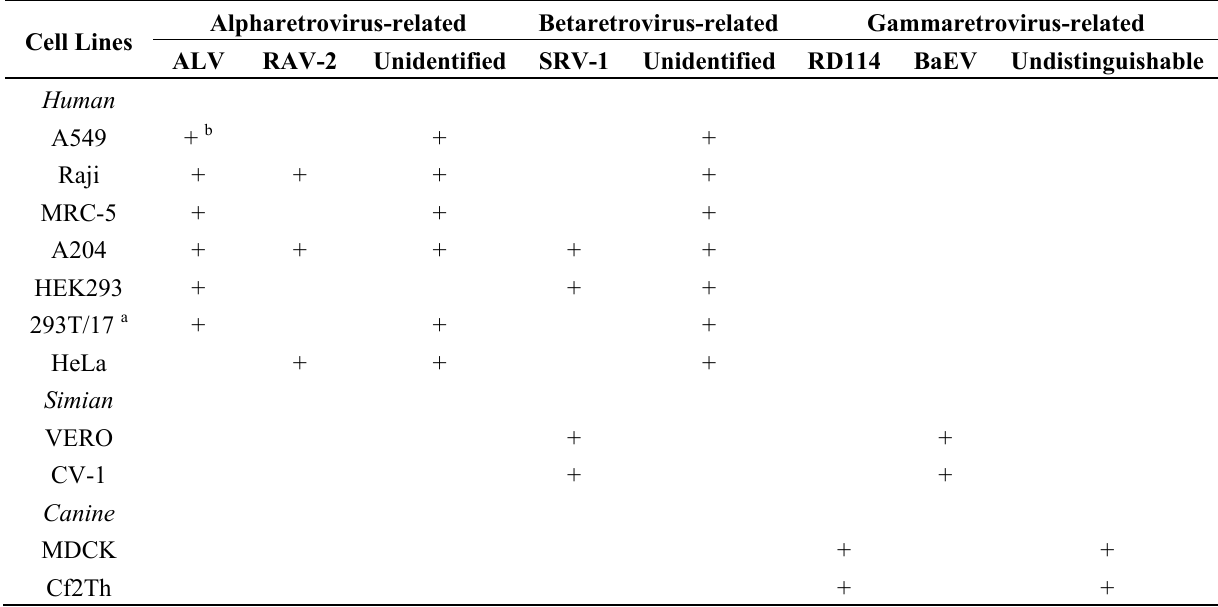
Table 3. PLEX-ID analysis of cell